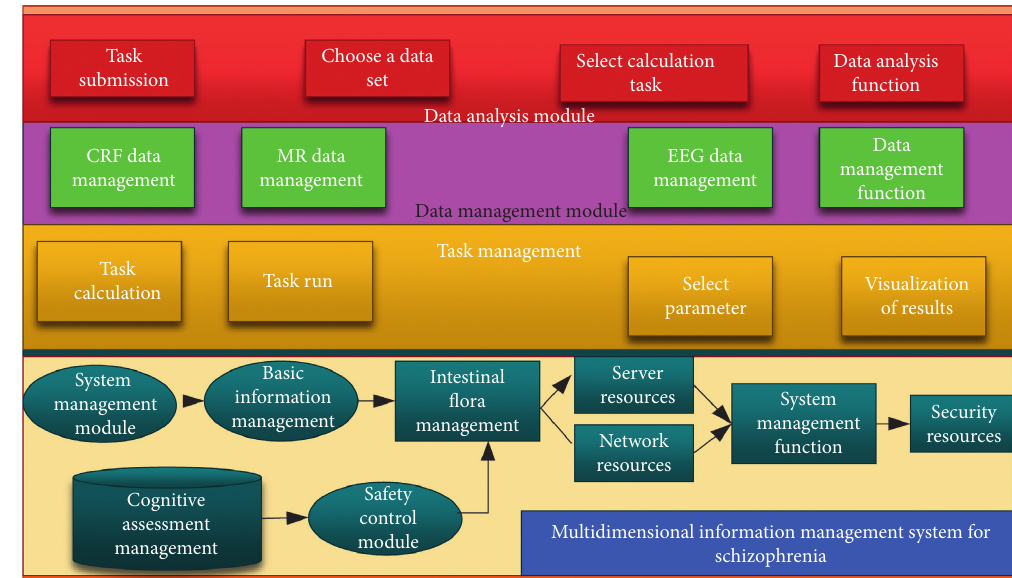
Figure 2: System function structure